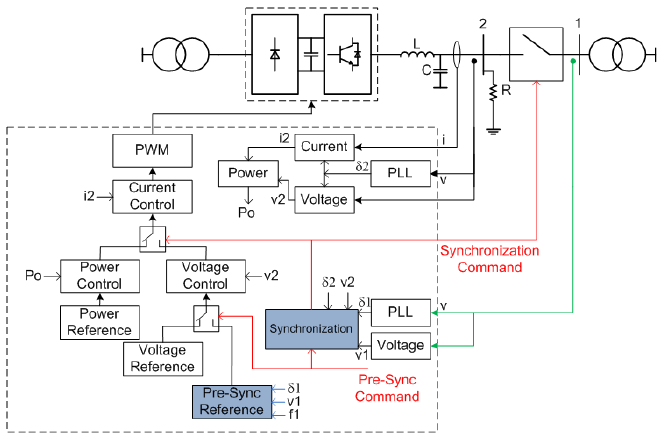
Figure 14. Control concept of grid-connected inverter.